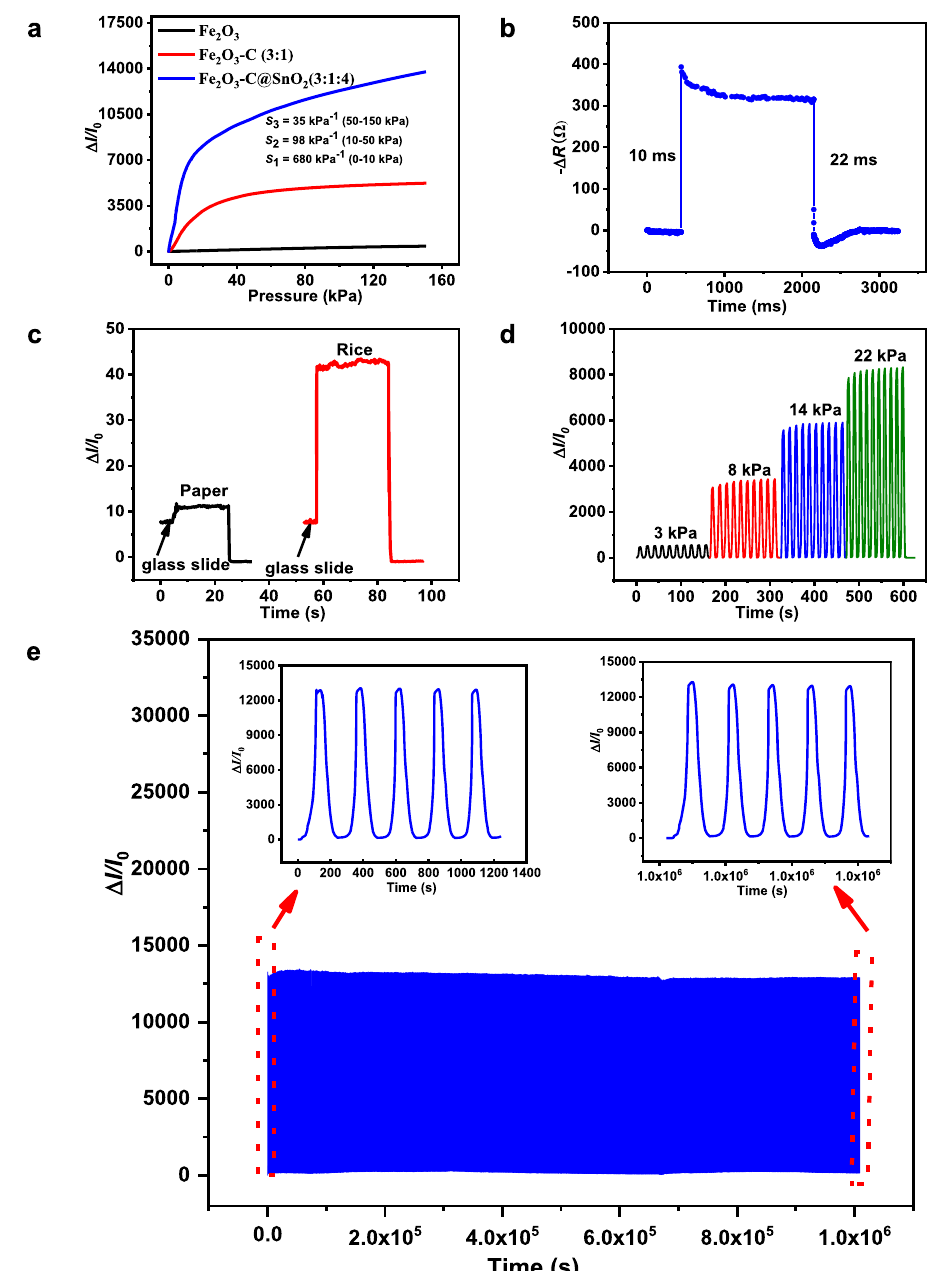
Fig. 4 Pressure-sensing characterizations. a The sensitivity of Fe 2 O 3 , Fe 2 O 3 /C with the mass of ratio of (3:1), and Fe 2 O 3 /C@SnO 2 with the mass of ratio of 3:1:4 based sensors. b Response time of Fe 2 O 3 /C@SnO 2 (3:1:4) pressure sensor. c Detection of low pressure: current curve of the proposed Fe 2 O 3